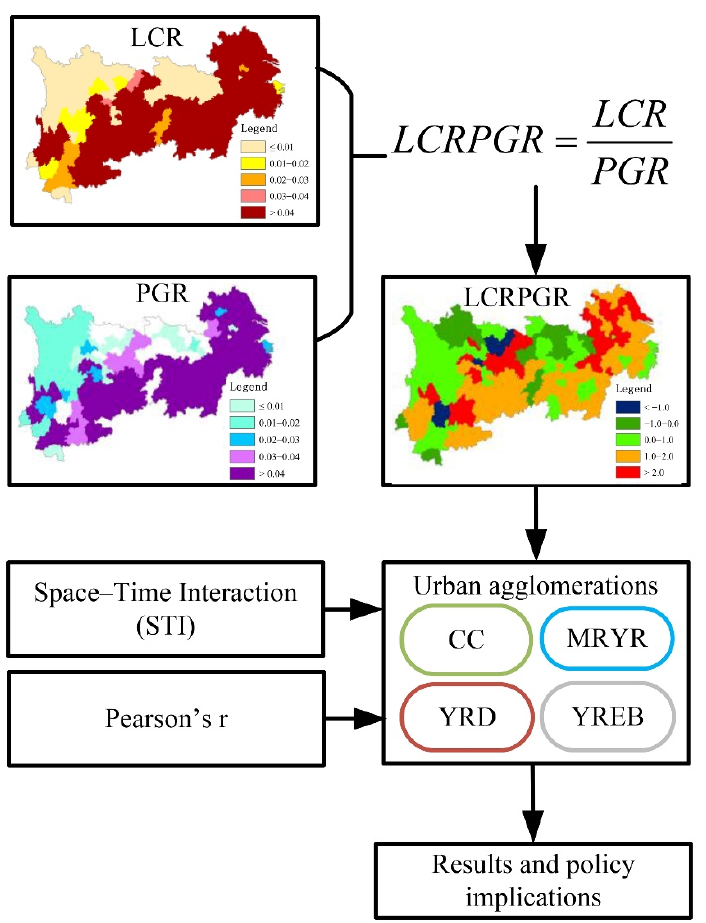
Figure 2. This study’s flowchart. CC: Chengdu–Chongqing; MRYR: Middle Reaches of the Yangtze River; YRD: Yangtze River Delta; YREB: Yangtze River Economic Belt.